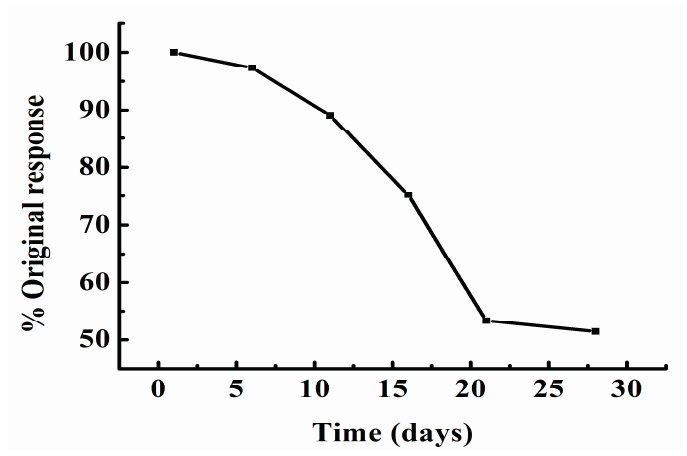
Figure 6. Stability of the response to 100 mg/L COD using FIA- thermal sensor observed for 28 continuous days. Samples were injected six times every day during this